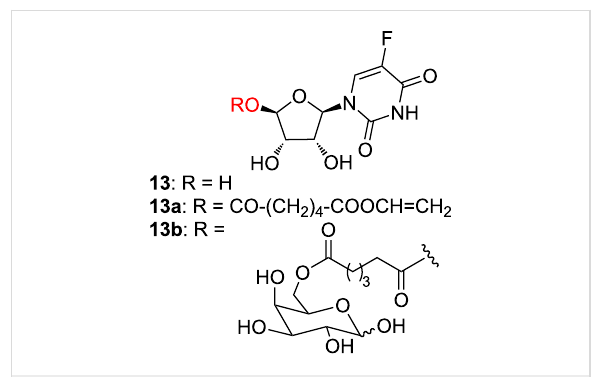
Figure 4: 5-Fluorouridine derivatives obtained by CAL-B